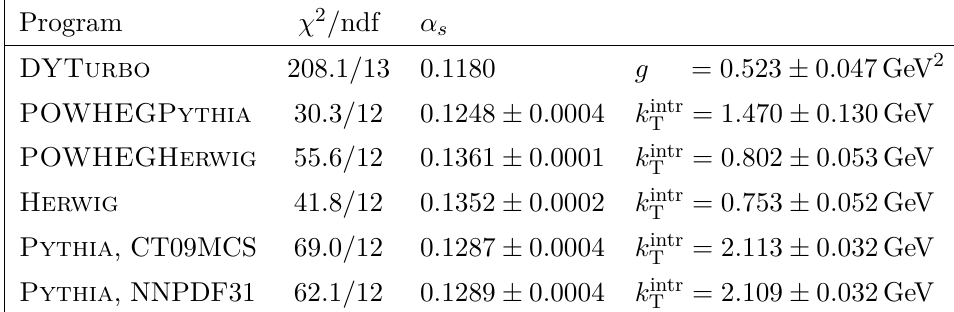
distribution. The uncertainties quoted are Table 2 . Results of fits of different models to the p Z T statistical, and the χ 2 comparison of the different models to the data is evaluated considering only statistical uncertainties. The right-hand column lists the fit values of the k intr parameter or, for T DYTurbo , the analogous g parameter. The fit with DYTurbo has one more degree of freedom than the fits with the other models since only one tuning parameter ( g ) is used for DYTurbo